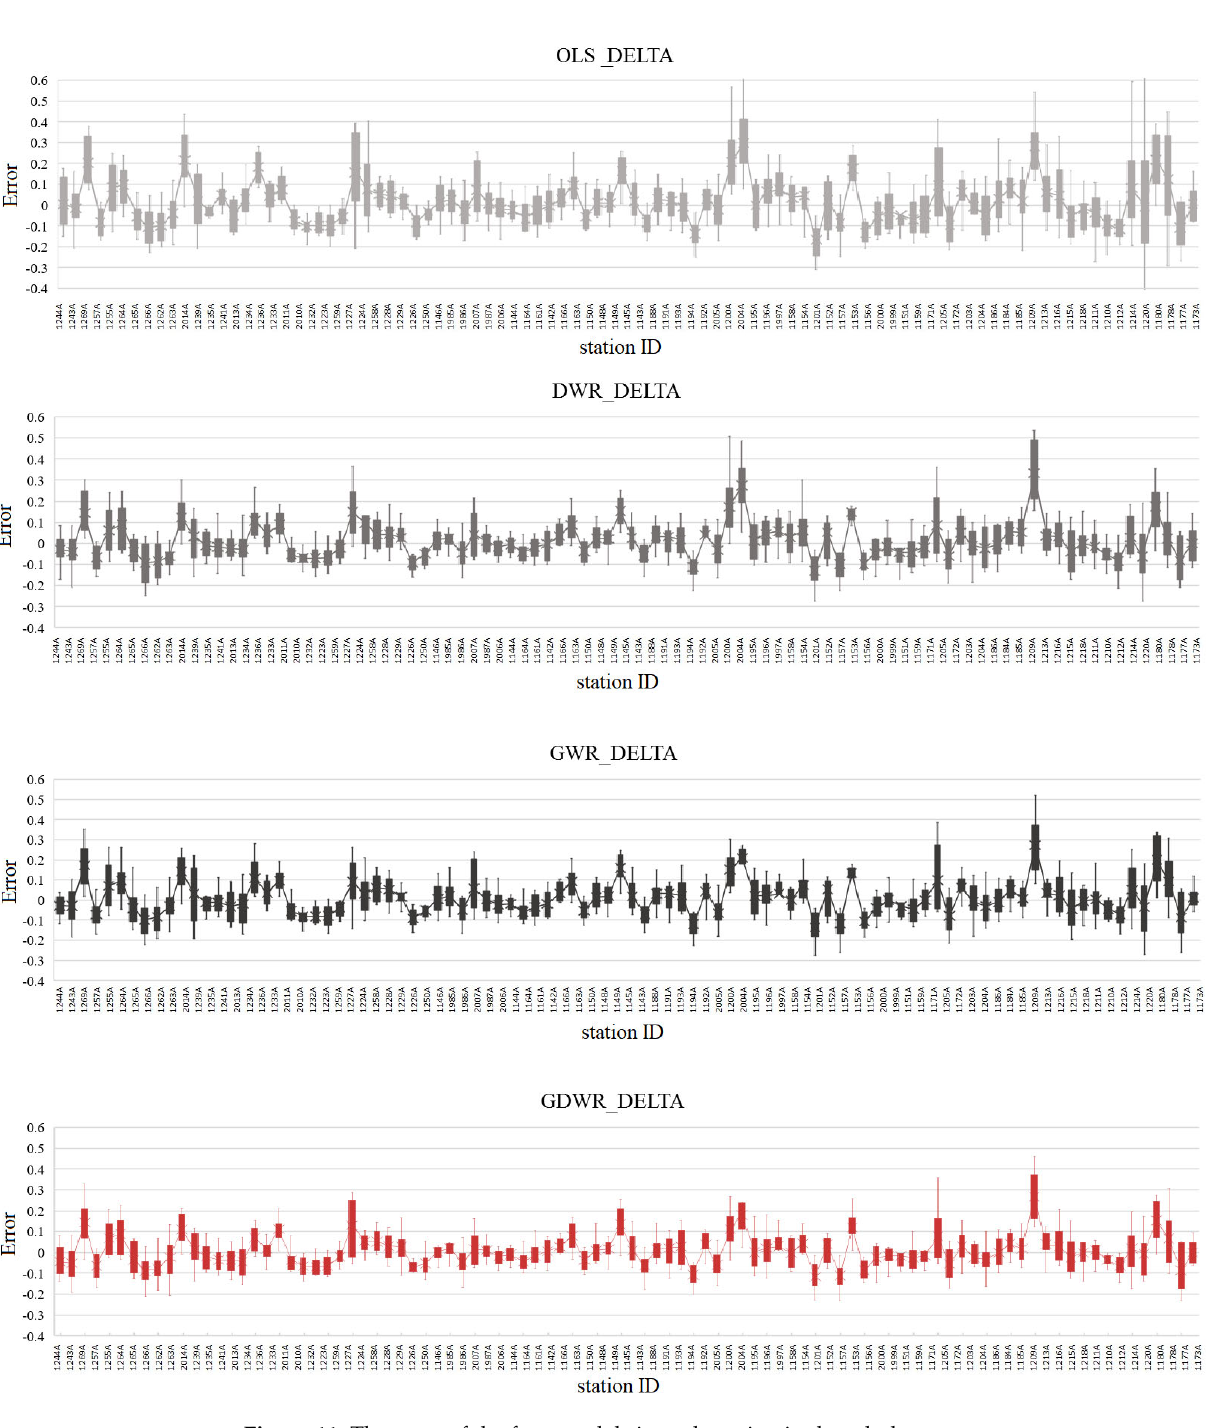
Figure 11. The error of the four models in each station in the whole year. Analysis of the above box plot reveals that the error responses of the four types of models at all stations throughout the year are similar, with the number of stations on the abscisic coordinate generating similar error curves, which indicates that the model fitting degree at all PM 2.5 monitoring stations exhibits the same reaction in space. Statistics show that the fitting accuracy at most sites is consistently high over 12 months, which is re ‐ flected by the fact that the error value varies around the zero axis within a small range, and only a small proportion of the site data exhibit a wide error range. Moreover, the box height is large, and only a small fraction of the site errors is large. By comparing the error responses of the different models, the OLS model yields the largest mean error and the largest fluctuation range in the whole year, which indicates that the model accuracy is relatively low from a microscopic perspective. The DWR and GWR models basically at ‐ tain the same performance. The GDWR model yields the smallest overall error at each site, and its fluctuation is smaller than that of the OLS, DWR, and GWR models. Based on the microscale response among the stations, it is found that, on the whole, the GDWR model achieves a better fitting effect than the other three models at all locations in space.